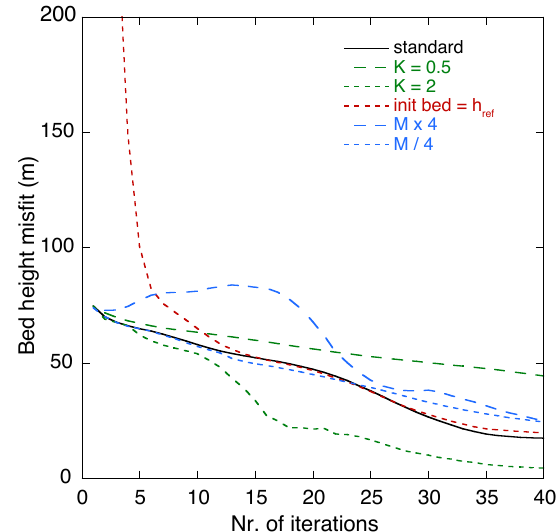
Fig. 4. The root-mean-square bed height misfit versus the number of iterations for experiments with varying relaxation factor K (green), initial bed (red) and balance gradient